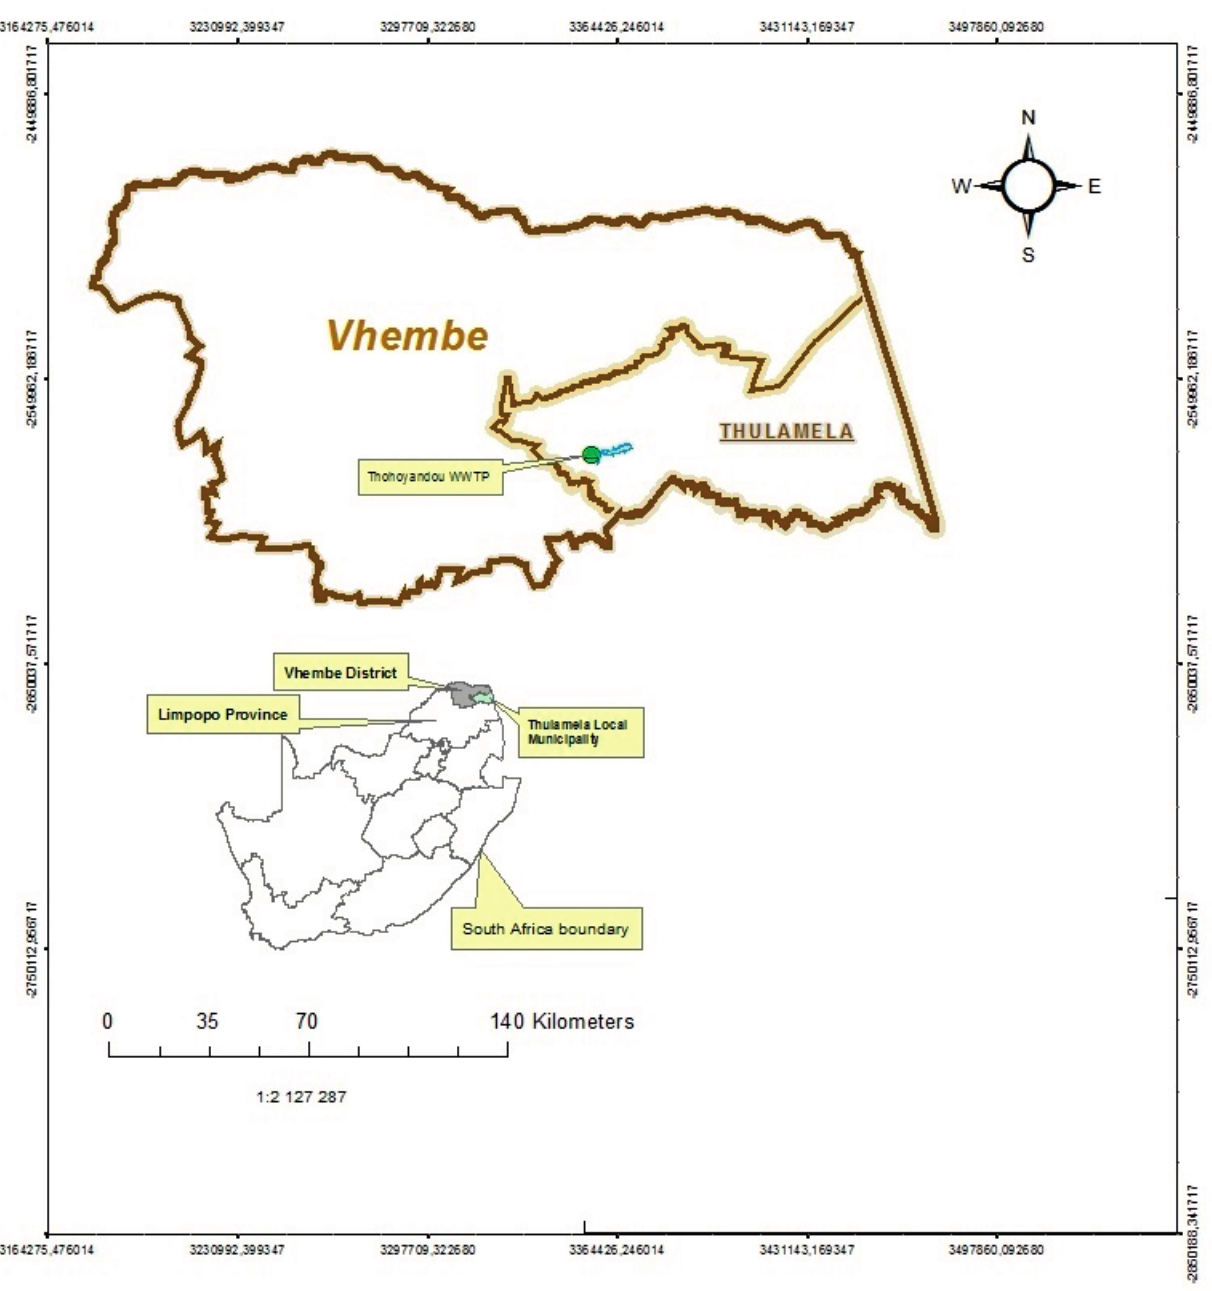
Figure 1. Map of the location of the WWTP in Muledane,